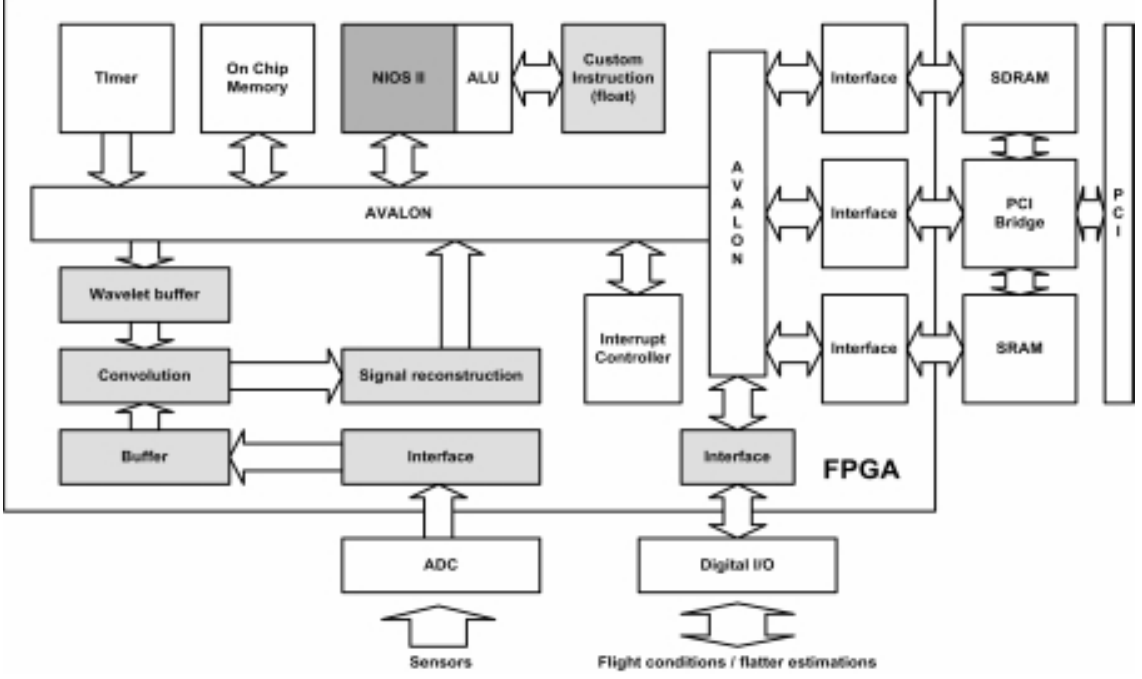
Fig. 3. Flutterometer hardware architecture; non-standard custom blocks implemented inside FPGA by authors, have grey background. responsible for signal acquisition from DACs, storing of the samples in a circular buffer, generation of addresses and control signals for memories containing wavelet and signal buffers, and synchronizing data feed with the actual calculations performed by multiple identical convolution and signal reconstruction units. Such an arrangement allows for easy scaling i.e. simultaneously performing a variable number of wavelet transformations of each of the variable numbers of input signals without consuming more time, with variable wavelets length in each channel